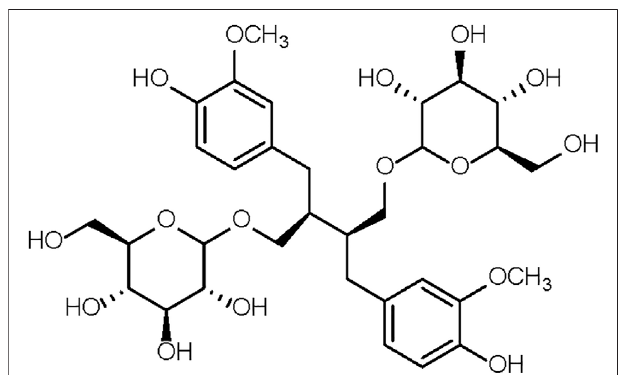
FIGURE 1 | The chemical structure of